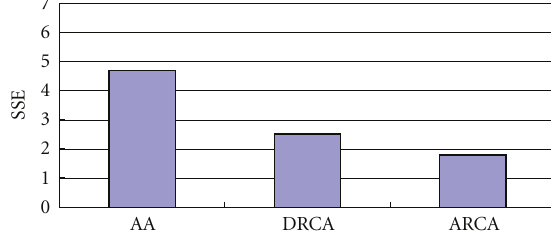
Figure 8: Sum of squared errors in Case